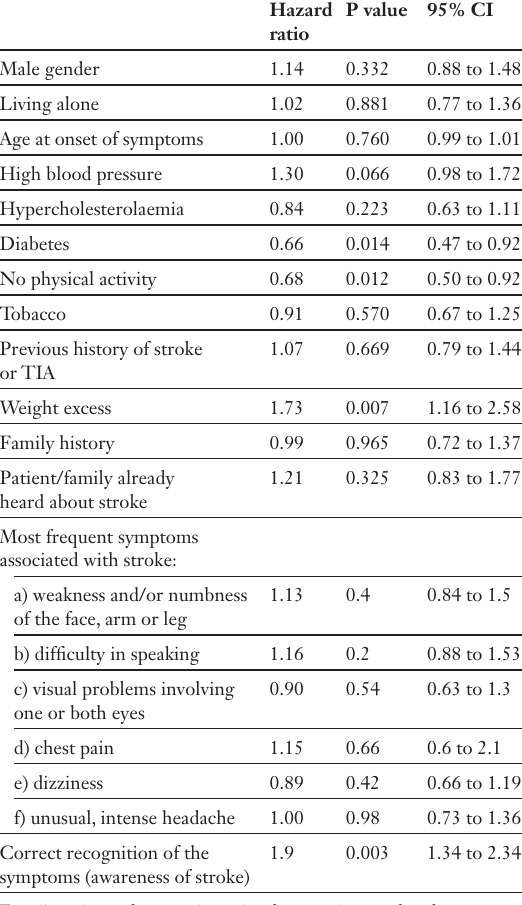
Prediction of patient’s cardiovascular risk factors, previous history of stroke/TIA and stroke knowledge on admission delays (n =